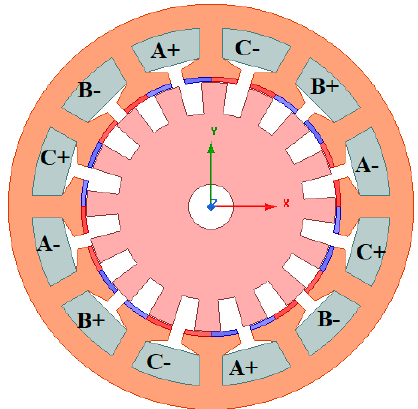
Figure 13. Schematic representation of 12-stator-slot/16-pole-rotor of FRM [32].